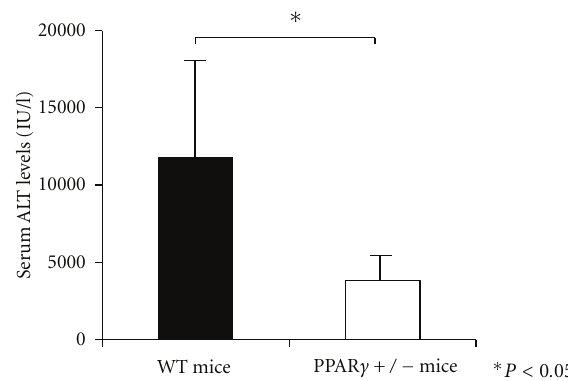
Figure 4: At 20h after Con A injection, the serum ALT levels in the WT mice were significantly higher than those in the PPAR γ + / −